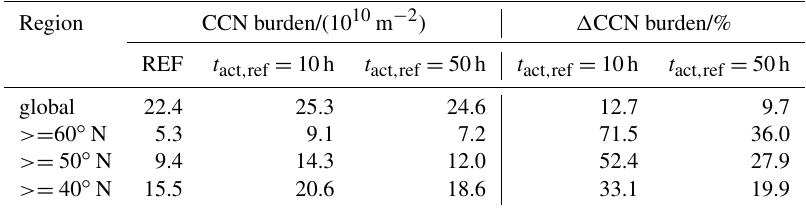
Table 2. CCN mean burden of the three simulations globally averaged and averaged over different regions in the Northern Hemisphere as well as the change due to consideration of CCN-active BC and POM particles in the externally mixed Aitken mode after heterogeneous O 3 oxidation.